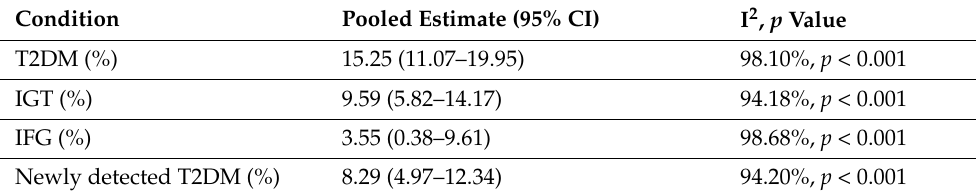
Figure 1. Flow diagram showing selection of studies for inclusion in the systematic review. Table 1. Pooled prevalence of T2DM, IGT, IFG, and newly detected T2DM in South